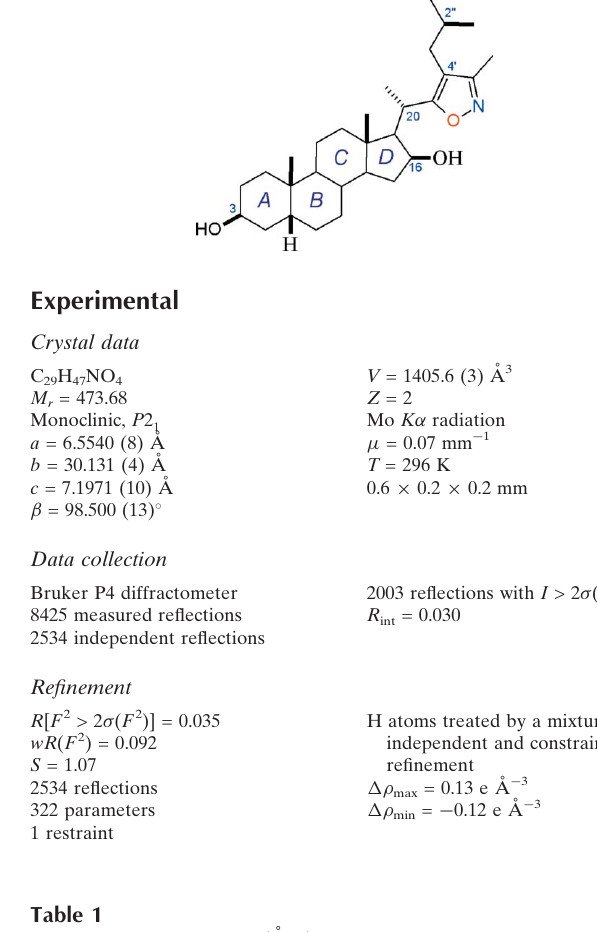
Hydrogen-bond geometry (A˚ , (cid:3)